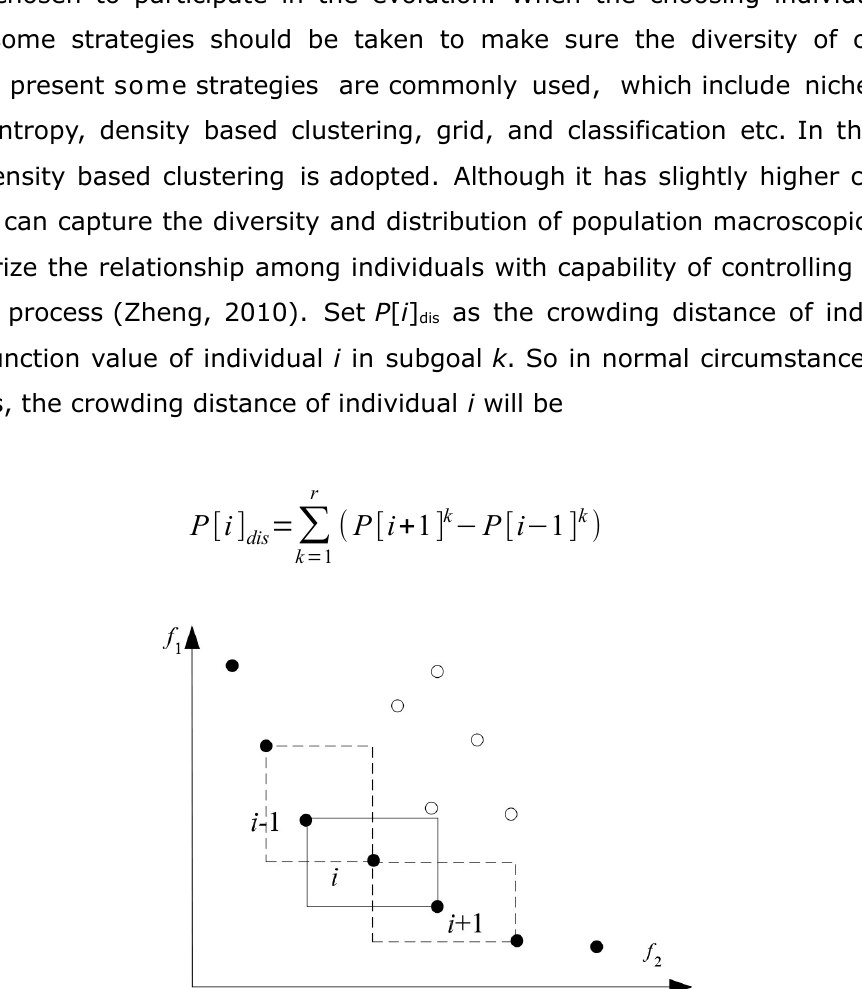
Figure 2. the crowding distance of two neighbouring